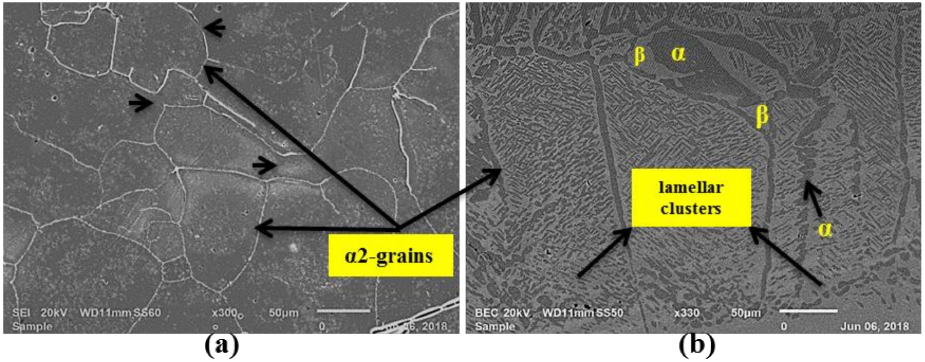
Figure 4. Heat treatment of sample 1 (the α 2 phase): at ( a ) 1200 ◦ C; and ( b ) 1430 ◦ C. There are interfacial grain boundary cleavages or dissolution (indicated by thick short